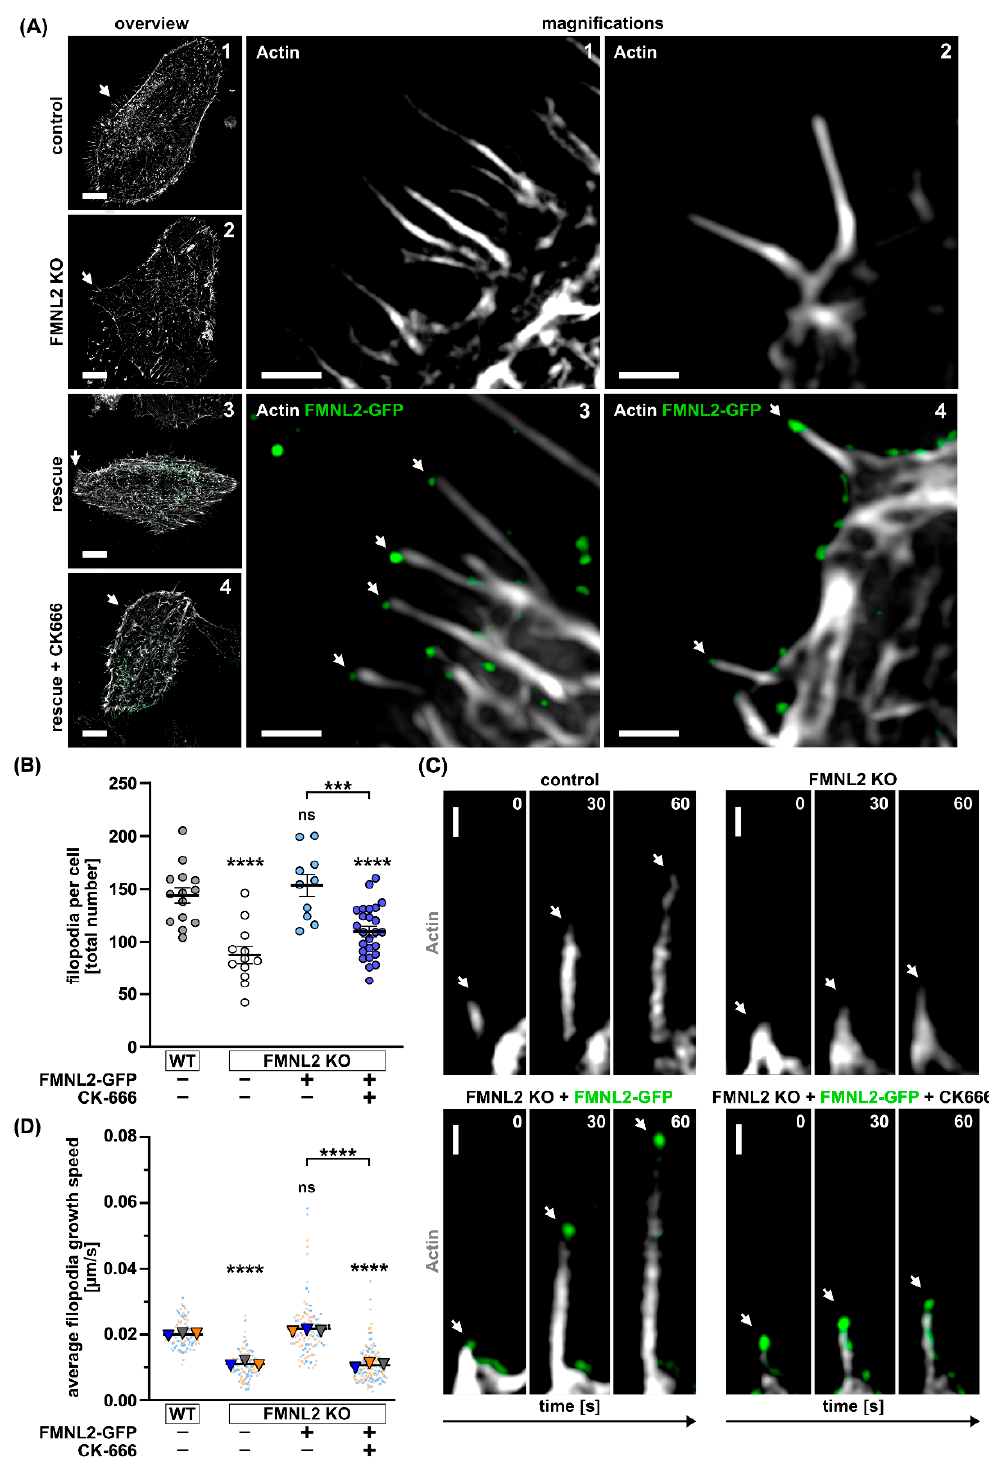
Figure 1. Filopodia formation in MCF10A cells depends on FMNL2 and Arp2/3 complex activity. Representative super-resolution live microscopy images of ( A ) MCF10A cells (Control = wildtype; FMNL2 KO; rescue = FMNL2 KO + FMNL2-GFP) transiently expressing actin-chromobody SNAP (white, SNAP-cell 647 SiR) and quantification of total filopodia per cell ( B ). Rescue cells were also treated with CK-666 (100 µM) for 30 min prior to imaging. White arrows in overview images (numbered from 1 to 4) indicate the location of magnified section with the corresponding number. Arrows in magnified images indicate FMNL2 (green) at the tip of filopodia (white). Scale bar (overview) = 10 µm. Scale bar (magnifications) = 1 µm. Data are shown as scatter plots with median (solid line) +/ − SEM. Each spot represents an individual cell from at least three independent biological